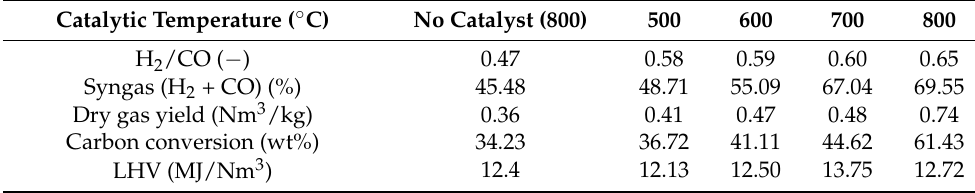
Table 1. Effect of catalytic temperature on properties of gas